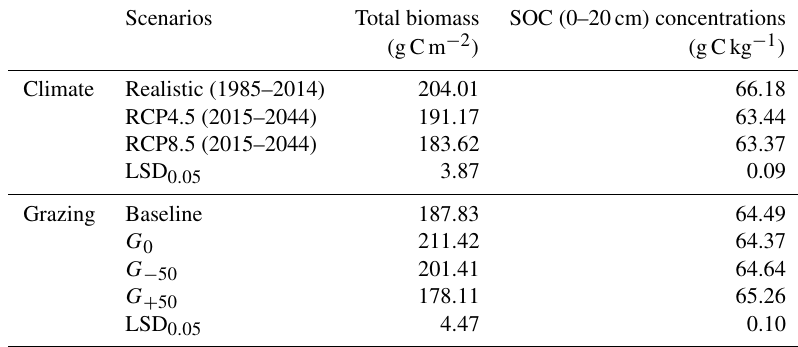
Table 3. The simulated SOC concentrations and total biomass under climate and grazing scenarios.